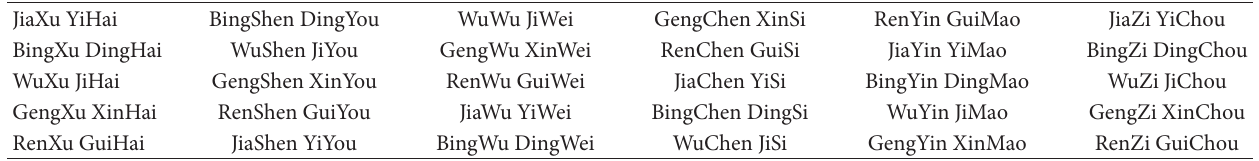
Table 2: The 5 by 6 array form of the new arrangement.